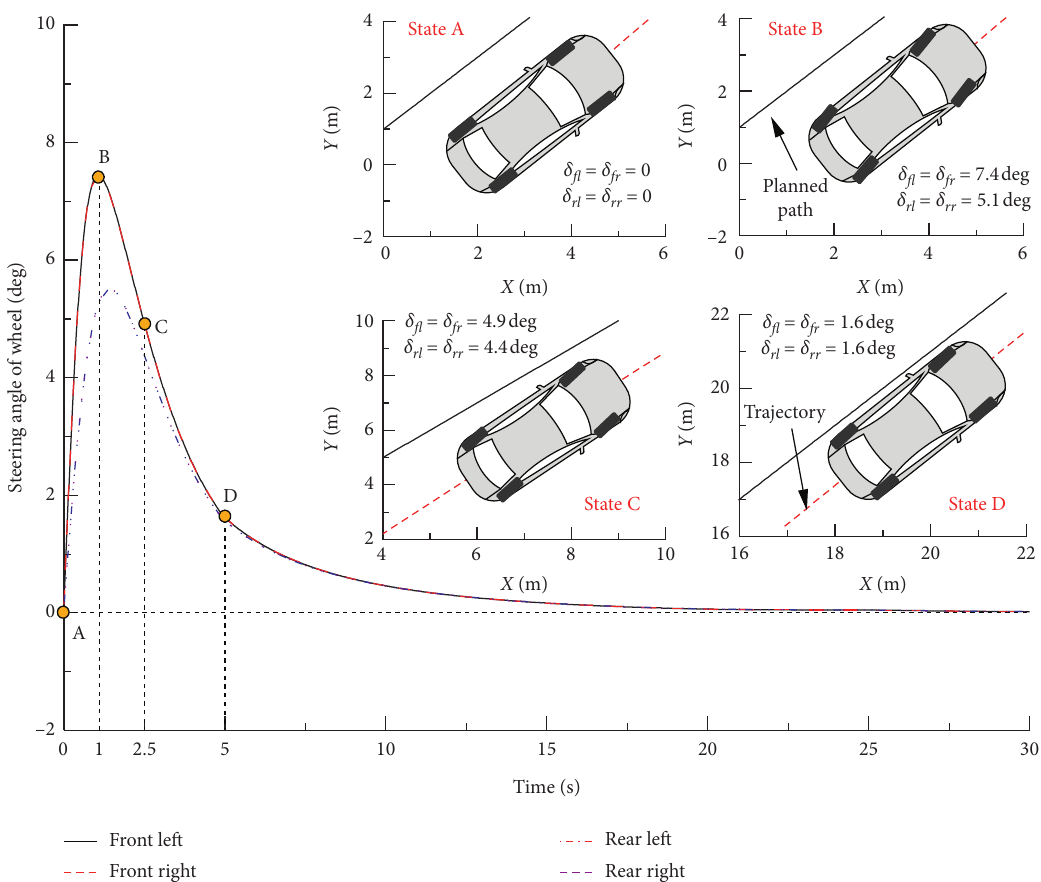
Figure 6: Time histories for steering angles of wheels of the vehicle in the straight path-following